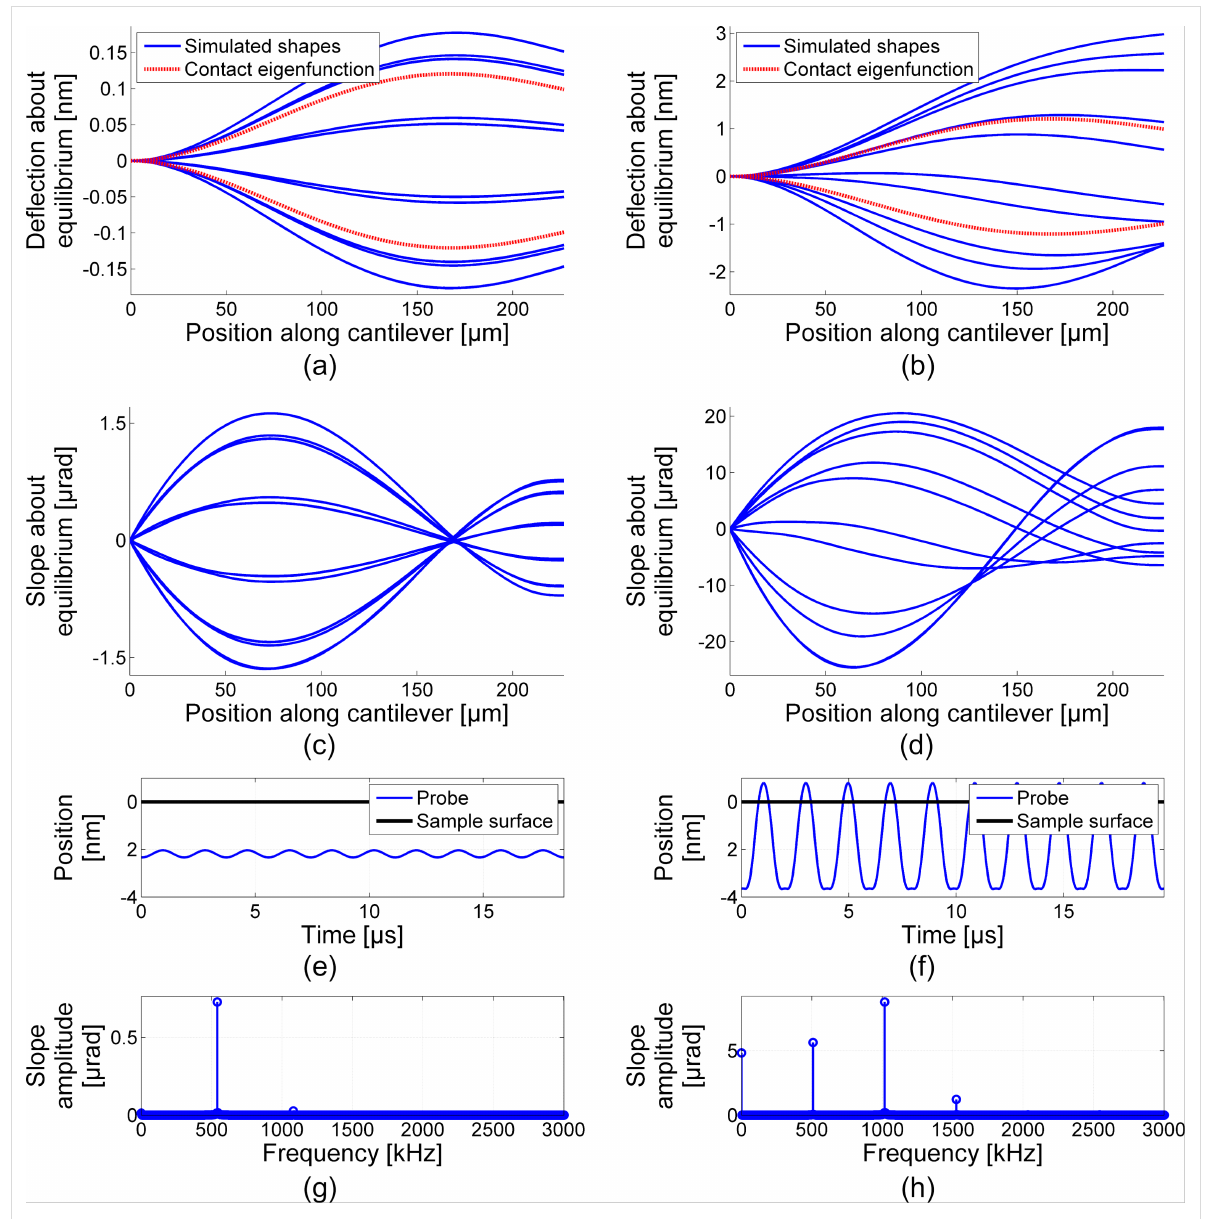
Figure 2: Detailed dynamic behavior of two numerical simulations at steady-state and at resonance: low bending moment amplitude of 1 N·m at 540 kHz (left column), and high bending moment amplitude of 15 N·m at 508.7 kHz (right column). (a, b) Stroboscopic depiction of cantilever deflec- tion and (c, d) slope shapes about static equilibrium (blue, solid), with linear eigenfunction of cantilever–sample system (red, dashed) overlay. (e, f) Probe tip path in time with depiction of the undeformed sample surface location for reference. (g, h) Frequency domain FFT of slope response to connect with direct observables in CR-AFM